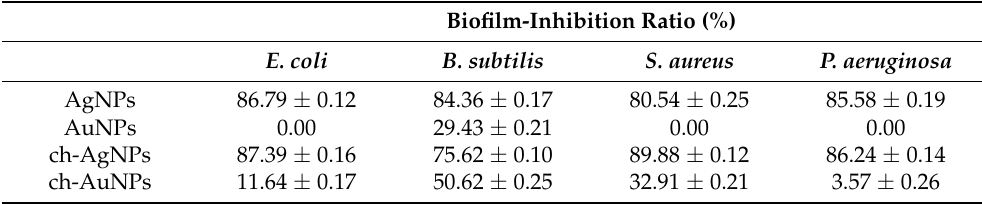
Table 1. Biofilm-inhibitory activity of the prepared chitosan–AgNPs and –AuNPs in comparison with biosynthesized